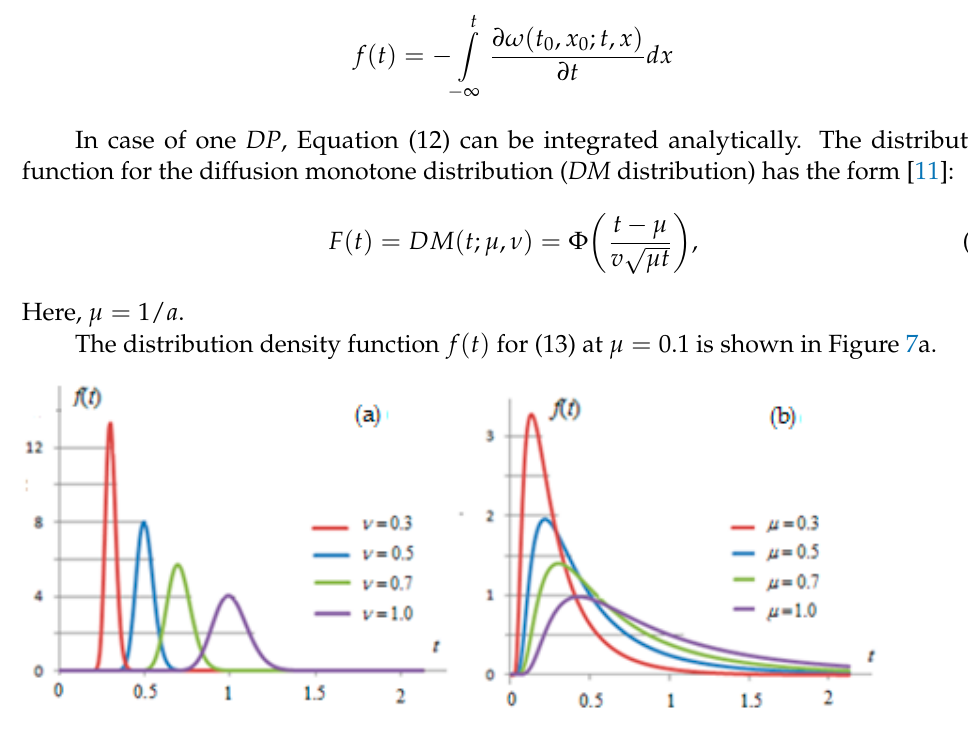
Figure 7. Diffusion distribution functions: ( a ) DM distribution; ( b ) DN distribution.